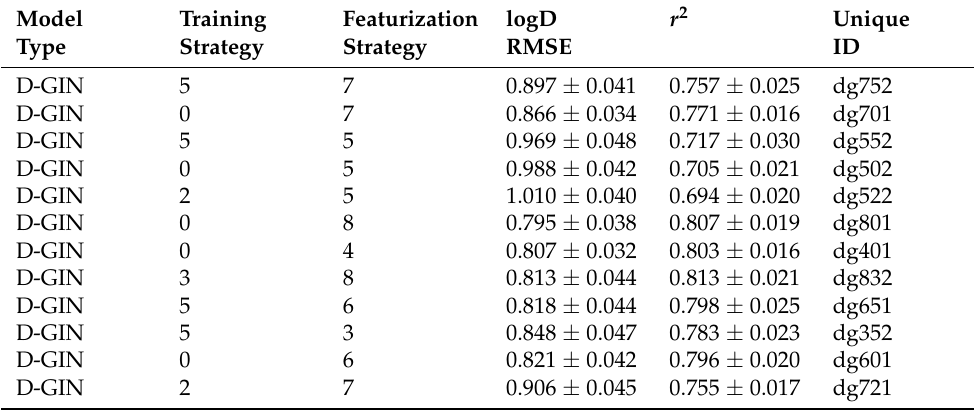
Table A12. Shows the logS RMSE and r 2 results for the D-GIN model type used during this survey. The last column consists of the unique identifier. Training strategy 0 represents a training strategy combining logD, logS, and logP, 1 represents a strategy combining logD and logP, 2 stands for a combination of logD and logS, 3 represents a strategy using logS and logP, 4 represents a strategy using logD, 5 represents a strategy using logS, and 6 represents a strategy using